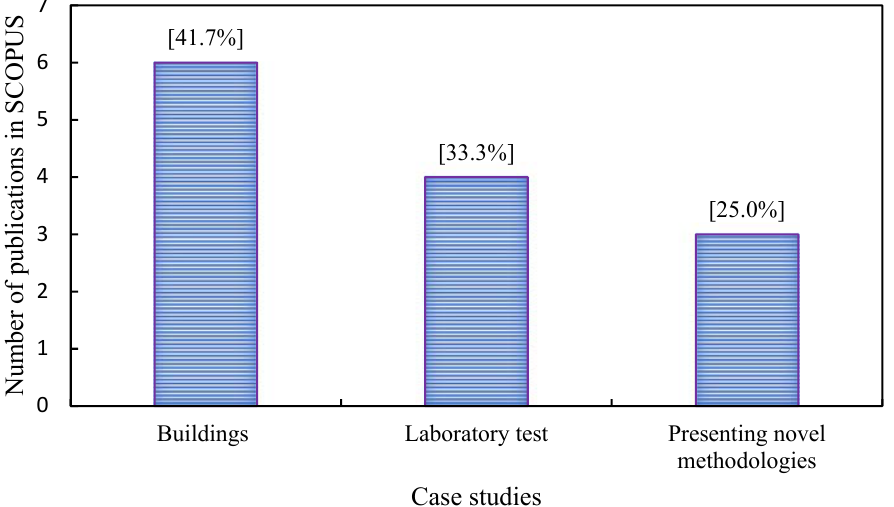
Figure 6. Classification of the articles associated with controlling of the air quality and the pollutions inside buildings. Group 1: focusing on building sector, group 2: conducting laboratory experiments, and group 3: presenting novel methodologies.